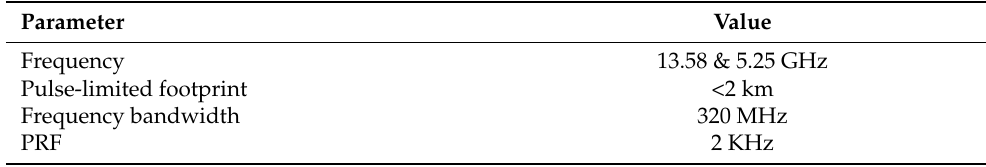
Table 1. Main parameters of the HY-2A/B radar altimeter.